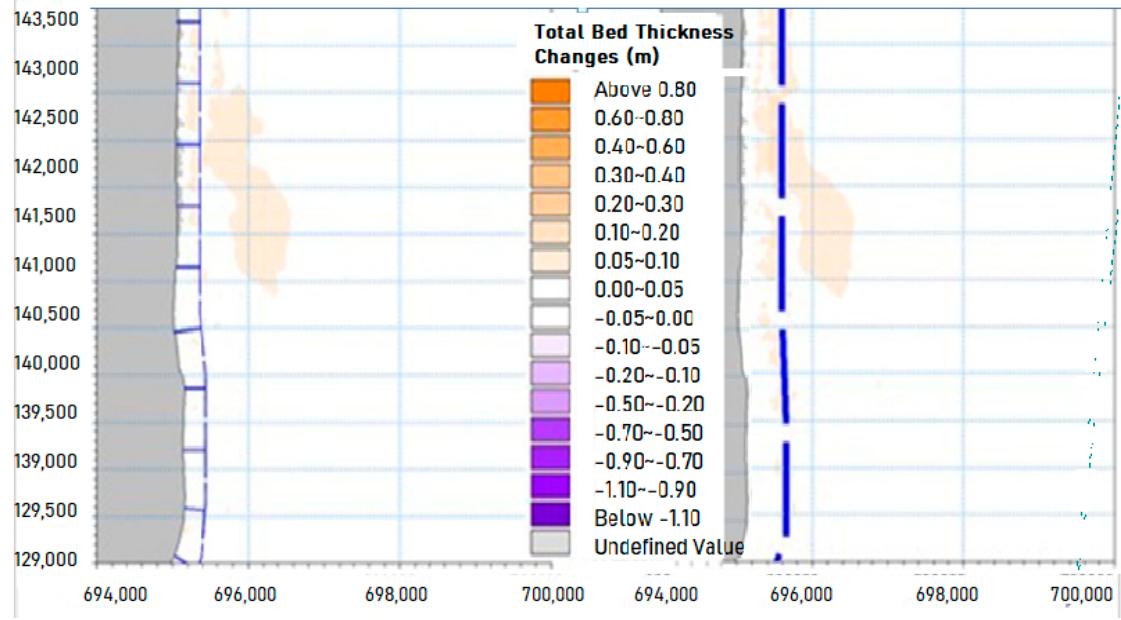
Table 6. Comparison of breakwater and sandbar impact by MIKE21.